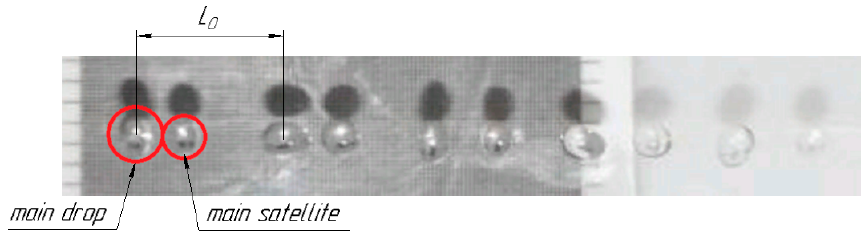
Figure 2. The decay of the jet into drops at the frequency of 240 Hz.